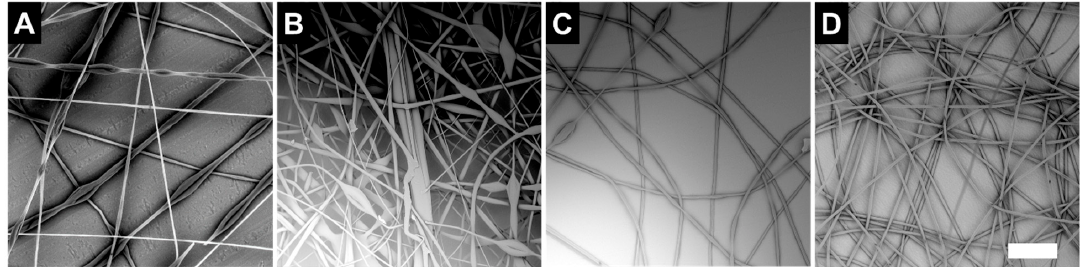
Figure 2. SEM micrographs showing the effect of LC formulation on fiber structure. Fibers spun from ( A ) 20 wt.% PS ( B ) 20 wt.% PS, 20 wt.% LC-1, ( C ) 20 wt.% PS, 20% LC -2, and ( D ) 20 wt.% PS, 20 wt.% LC-3 with a 100 micron scale bar.